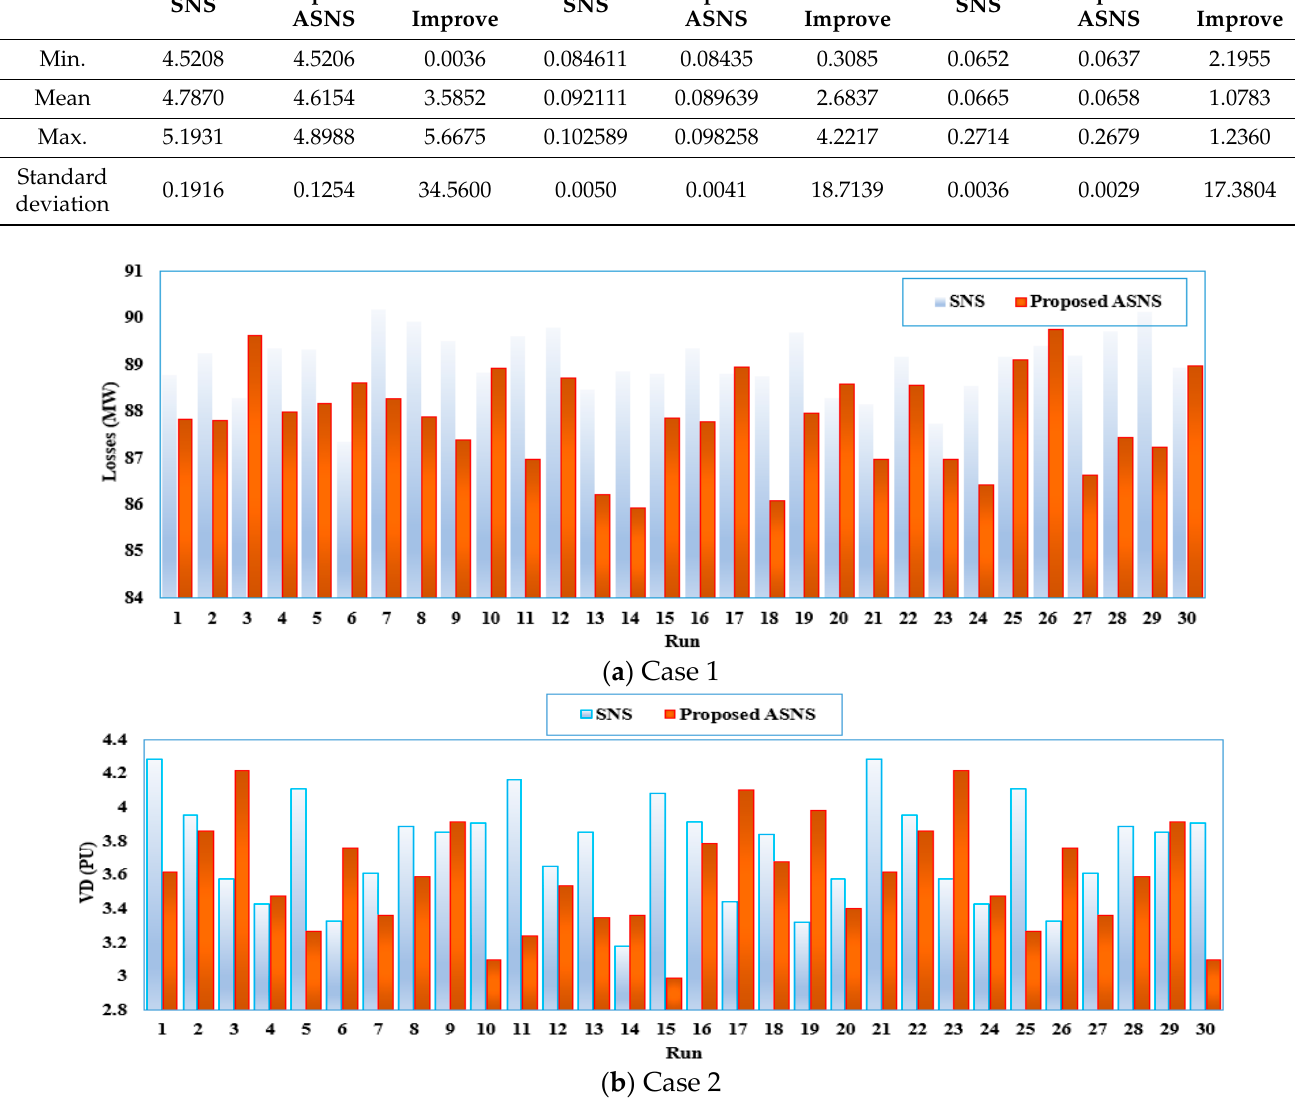
Figure 16. Obtained fitness values for SNS and proposed ASNS of the IEEE 118-bus grids. Table 15. Absolute difference between the best and worst of SNS and ASNS for minimizing the losses (Case 1) for the IEEE 30-bus